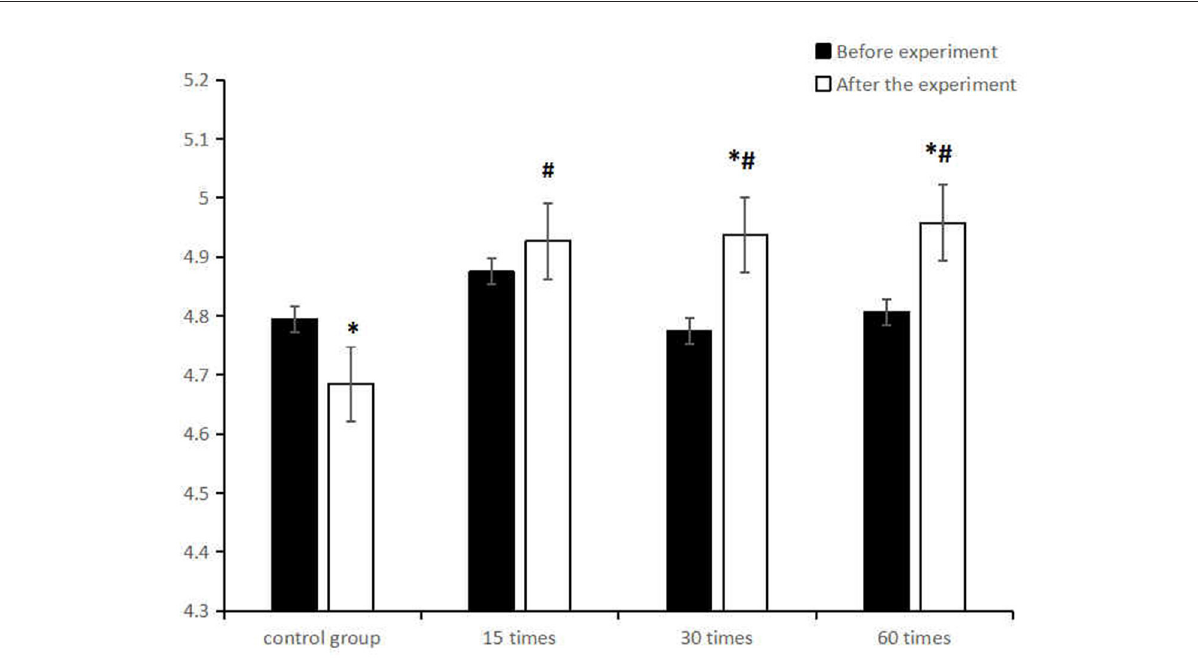
FIGURE2 Comparison of the mean (M ± SD) uncorrected distance visual acuity between the control group and the ciliary muscle training group with different frequencies before and after the experiment. *represents significant difference in intra-group comparison ( p < 0.05), # represents significant difference in comparison with the control group after the experiment ( p <